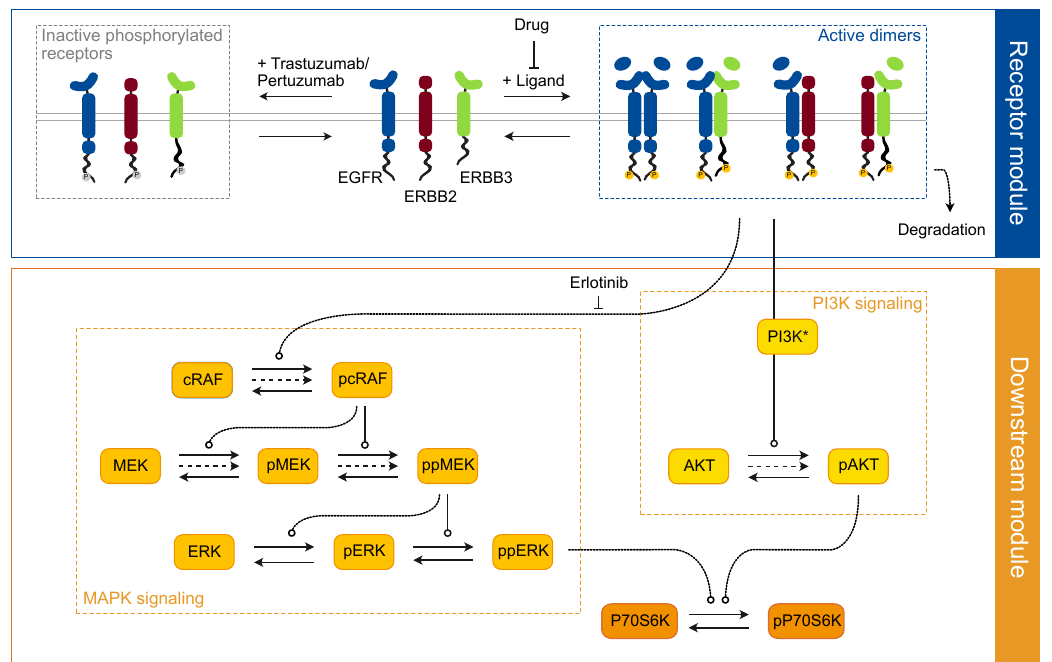
Figure 2. The structure of the mathematical signaling model. Receptor module: The ERBB receptors EGFR, ERBB2 and ERBB3 form several homo- and hetero-dimers upon ligand binding, which lead to their trans-phosphorylation and thereby activation (dotted blue box ’Active dimers’) and eventually to their degradation. Pertuzumab and trastuzumab exhibit an additional function, inducing the ligand- independent phosphorylation of receptors (dotted grey box ’Inactive phosphorylated receptors’). Downstream module: Activated receptors signal downstream through the MAPK and PI3K cascades (the respective dotted yellow boxes) ultimately converging in the phosphorylation of P70S6K. Drugs inhibit the formation of active dimers and thus downstream signaling. Reactions are represented by arrows, dashed lines indicate basal reaction fluxes. The asterisk indicates a mutation in